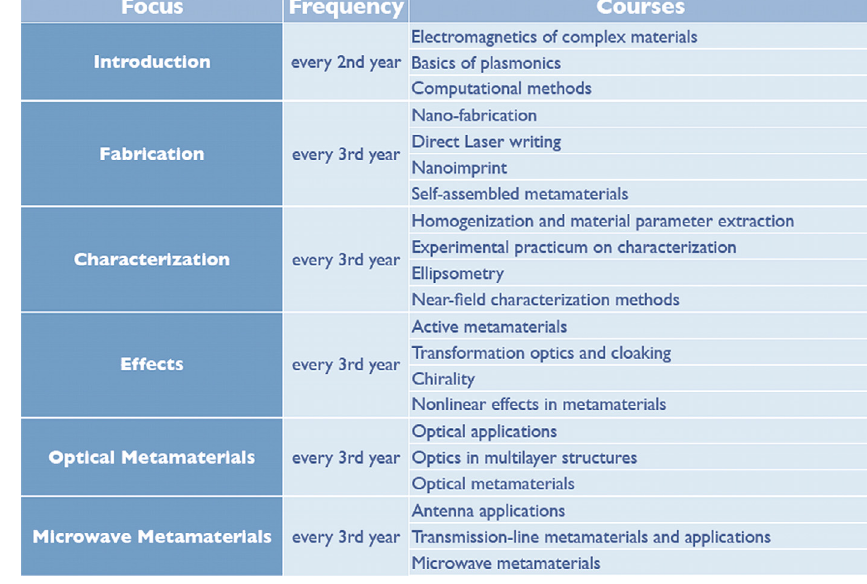
Figure 3. Program of the core courses offered by